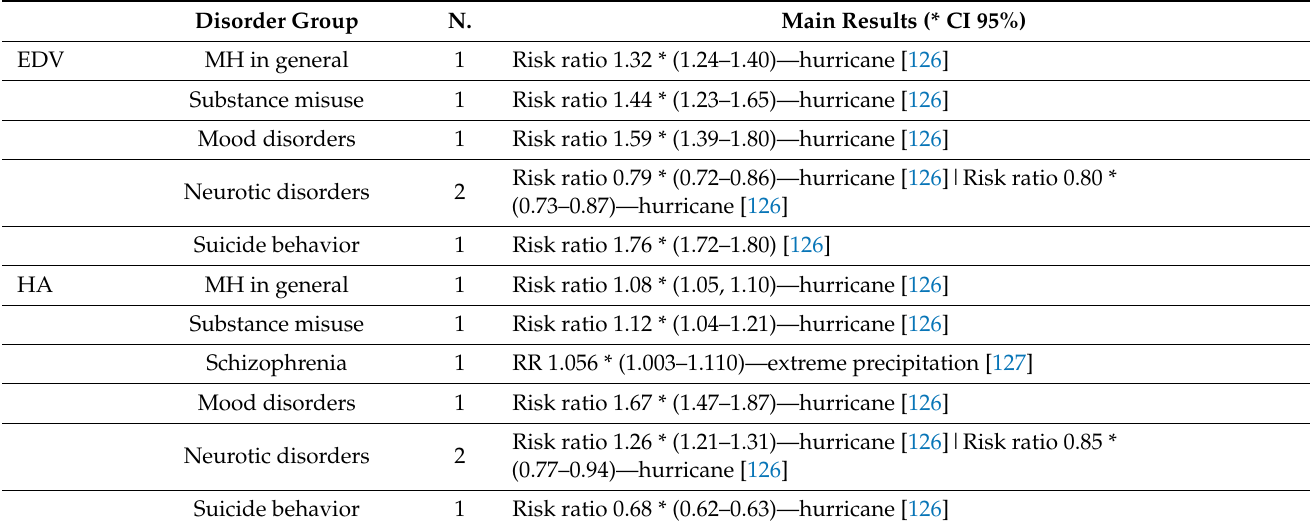
Table 3. Extreme